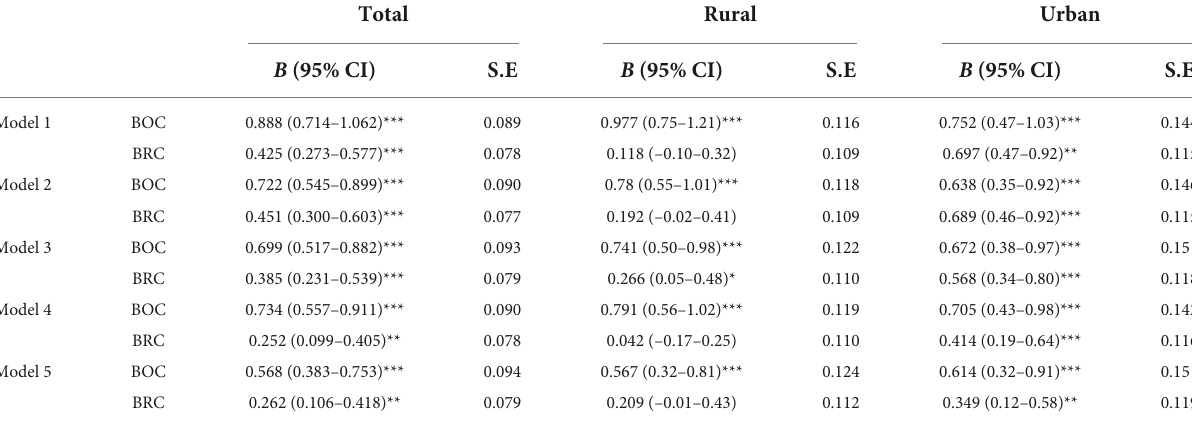
TABLE 5 The relationship between personal social capital and European Five Dimensions Questionnaire Visual Analogue Scale (EQ-VAS). Total